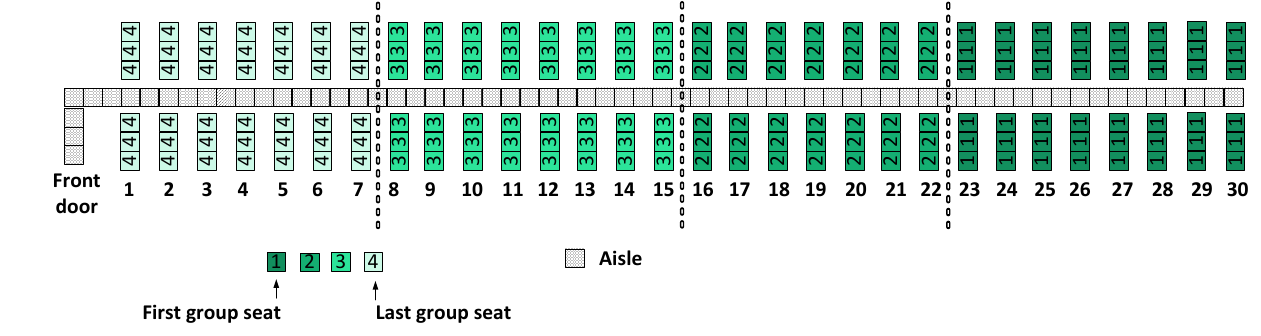
Figure 4. Back-to-front-by-4-groups.